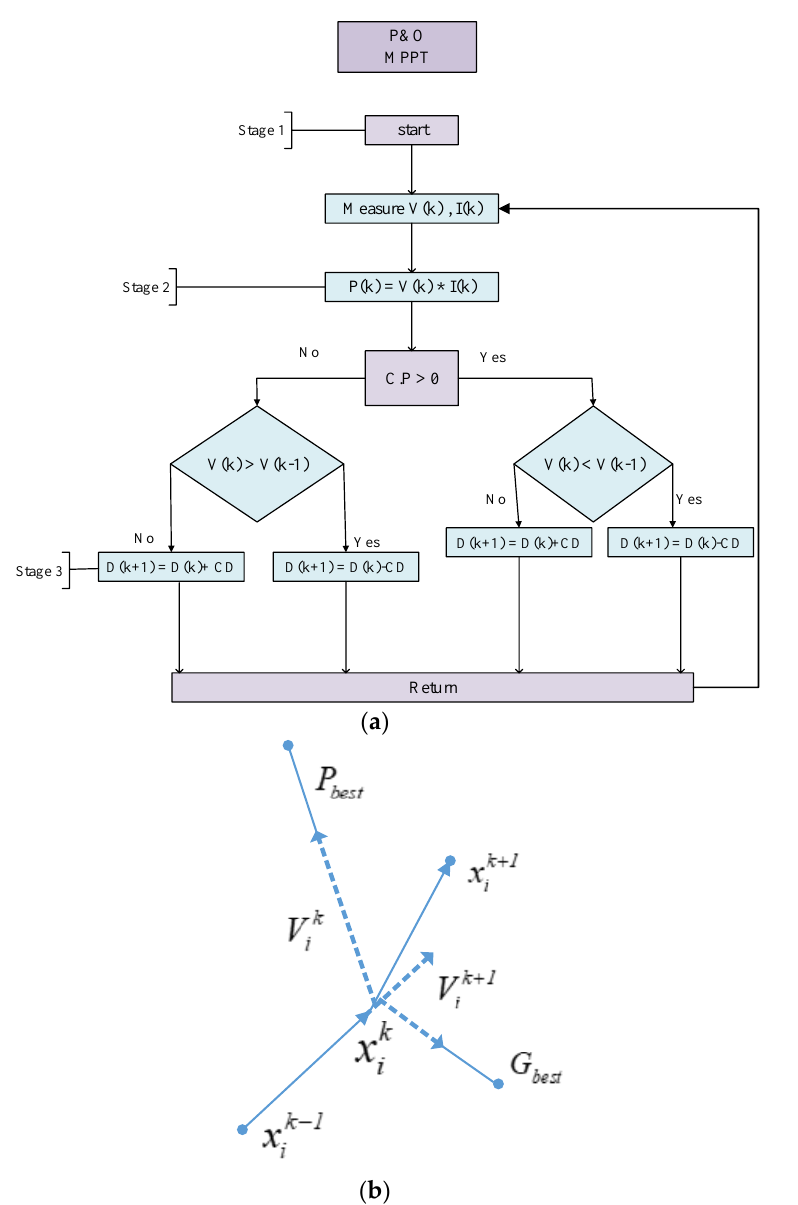
Figure 4. Different stages in the P&O scheme: ( a ) The flow diagram of the P&O MPPT scheme. ( b ) Particle movement during optimization.